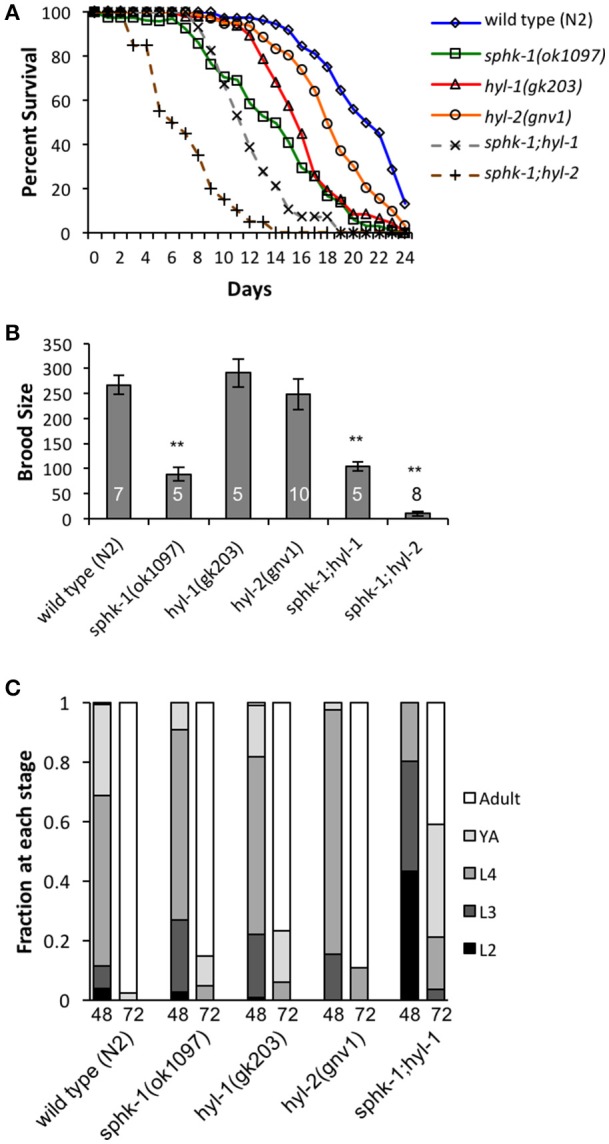
Sphingolipid enzymes regulate life history traits. (A) Lifespan curves of wild type, sphk-1, hyl-1, sphk-1;hyl-1, hyl-2, and sphk-1;hyl-2. For all animals, all days are counted relative to egg lay. Significant differences in lifespan and mean survival were determined using a Kaplan-Meier estimator and Log-rank tests (Yang et al., 2011). (B) Brood size of animals of the indicated strain (n values are indicated). L4 animals were singled onto individual plates every 24 h for 6 days, and hatched eggs were counted 2 days after removal of the parent, representing a surviving population. For brood size, **p < 0.001 and significant differences were determined by one-way ANOVA and Tukey's HSD post-hoc tests. (C) Developmental level of wild type, sphk-1, hyl-1, sphk-1;hyl-1, and hyl-2 at 48 and 72 h after a 2 h egg lay. Error bars are ± SEM.